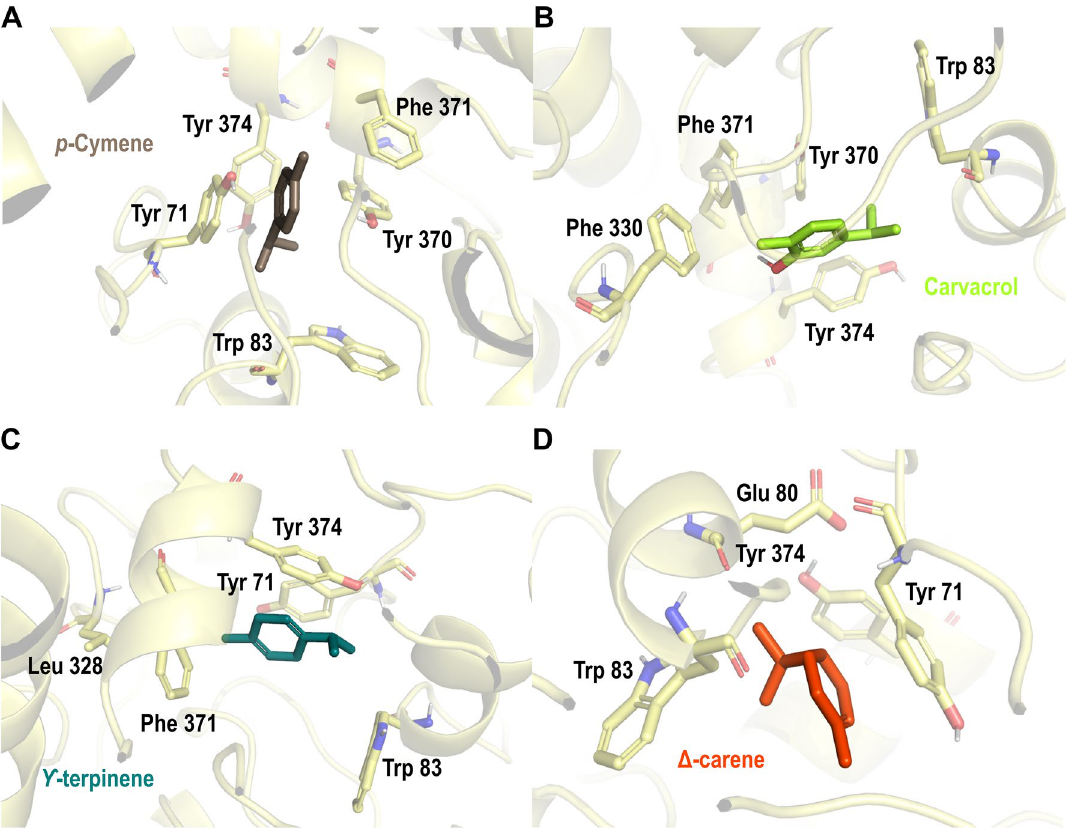
Figure 9. Docking poses of Best ranked plant secondary metabolites on the acetylcholinesterase crystal structure (PDBid: 1QON). ( A ) p -cymene; ( B ) carvacrol; ( C ) γ-terpinene; ( D ) Δ 3 -carene. Acetylcholinesterase’ residues are colored according to the atom type of the interacting amino-acid residues (protein’s carbon, pale yellow; oxygen, red; nitrogen, blue). The protein–ligand interactions are represented by dash lines as follows: hydrogen bond interactions are colored in yellow, and -π interactions are colored in